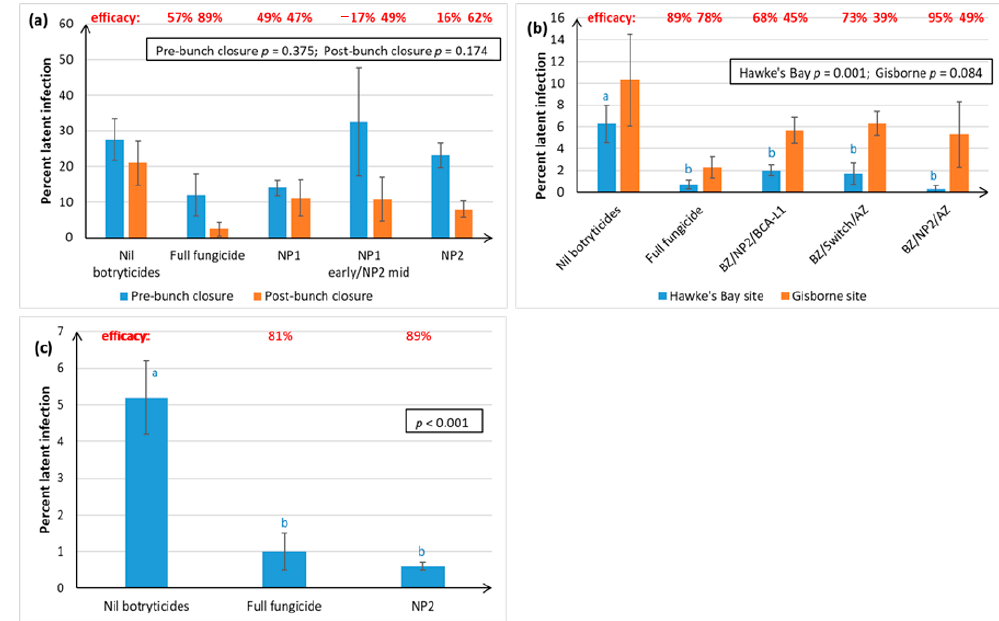
Figure 1. Percent incidence of Botrytis latent infections (latents) on immature berries from Chardonnay and Sauvignon Blanc grape varieties, following freezing and incubation in high humidity chambers. The efficacy (E) of each spray programme for Botrytis control (shown in red text) was calculated using the formula, E = ((U − T)/U) × 100, where T is the percentage of latents in the test treatment and U is the percentage disease in the Nil botryticide control. A negative E value indicates that disease is higher in the treatment than in Nil botryticide control. Treatments are described in full in Tables S1 and S2, but briefly comprised: Nil botryticides (negative control), where 1–3 sprays of a powdery mildew-specific fungicide were applied and no botryticides; full fungicide (positive control), where a mixture of fungicide products were applied at 7- to 21-day intervals from late-November through to mid-March to provide season long disease control; NP1 and NP2, which were applied 1–4× during the early- and mid-season of phenological development, i.e., between post-bloom and post-bunch closure. For the NP treatments, BOTRY-Zen ® (BZ, 4 kg/ha formulation of the biocontrol agent, Ulocladium oudemansii ) was also applied during the remainder of the early-season, and BCA-L1, an experimental formulation of Aureobasidium pullulans (2 × 10 7 spores/mL) was applied during the late season (mid-February to mid-March) to provide season-long disease control using only biopesticide products. Switch ® fungicide (800 g/ha) and ARMOUR-Zen (AZ, 5 L/ha formulation of chitosan) were sometimes used as alternative mid- and late-season treatment comparisons. Each lettered graph represents a separate experiment, set up in a randomised block design. Different ascending numbering systems are used for Chardonnay vs. Sauvignon Blanc experimental seasons to indicate that trials for both varieties were performed over consecutive seasons, but that season 1 in Chardonnay does not necessarily correspond to the same calendar year as Season i in Sauvignon Blanc. On each graph, error bars indicate standard errors, and the boxed values provide the probabilities obtained from analysis of variance (ANOVA). Different letters indicate statistically significant differences from pairwise likelihood ratio tests but are only presented when the ANOVA p ≤ 0.05. The concentration of the active ingredient in the NP formulation is indicated in parentheses for each specific experiment. ( a ) Chardonnay, Season 2, Hawke’s Bay site, with assessments at two times—pre-bunch closure and post-bunch closure, NP1 (7 g/L) and NP (15 g/L); ( b ) Chardonnay, Season 4, with two assessment sites—Hawke’s Bay and Gisborne, NP2 (5 g/L); ( c ) Sauvignon Blanc, Season i, Hawke’s Bay site, NP2 (5 g/L).